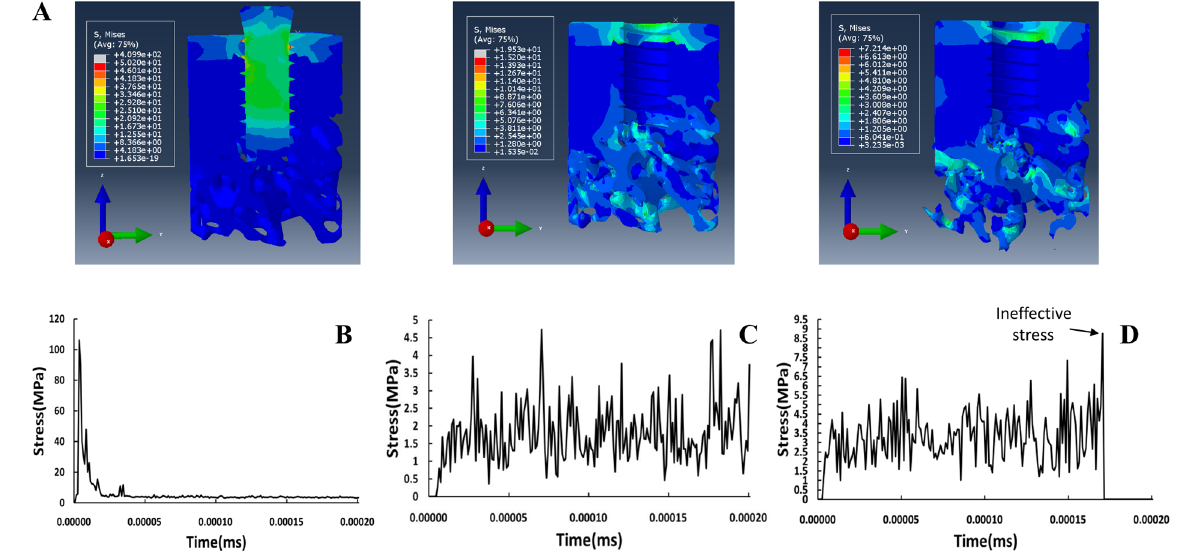
Figure 7. The response of bone tissue surrounding the implant after impact loading. All the figures presented were from Abaqus 6.13 software (Dassault System, Simulia Corp, USA). ( A ) The distribution of stress in bone tissue during impact loading and the subsequent prorogation of stress waves. ( B ) Stress-time curve for cortical bone under impact loading. ( C ) Stress-time curve for cancellous bone under vertical impact loading. ( D ) Stress- time curve for cancellous bone under impact loading at 45°.